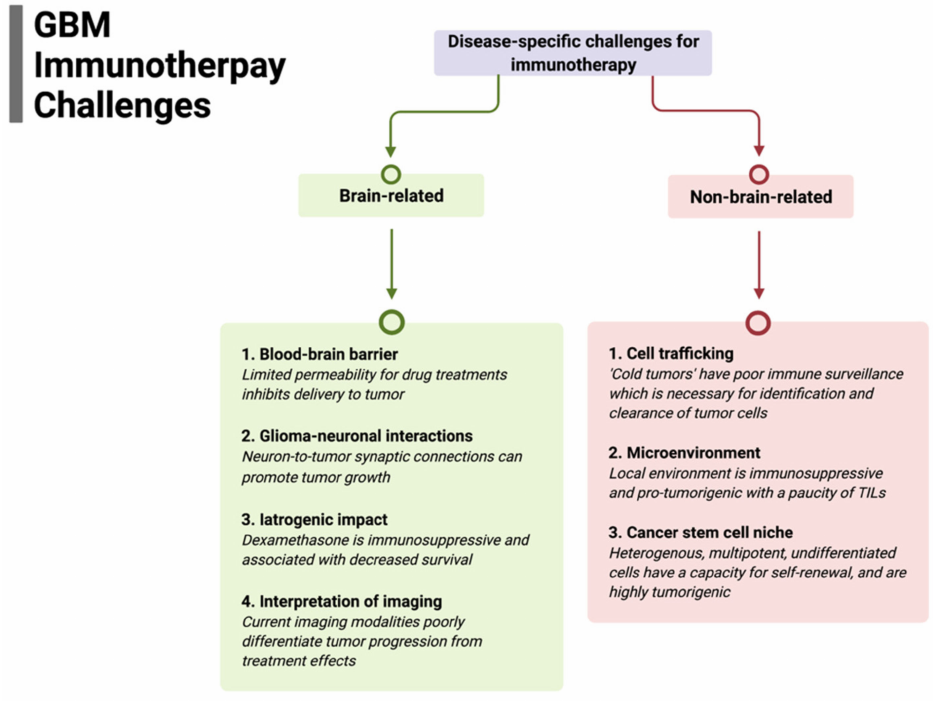
Figure 1. Summary of disease-specific challenges for glioblastoma immunotherapy divided by specific brain-related and non-brain-related challenges that need to be overcome for